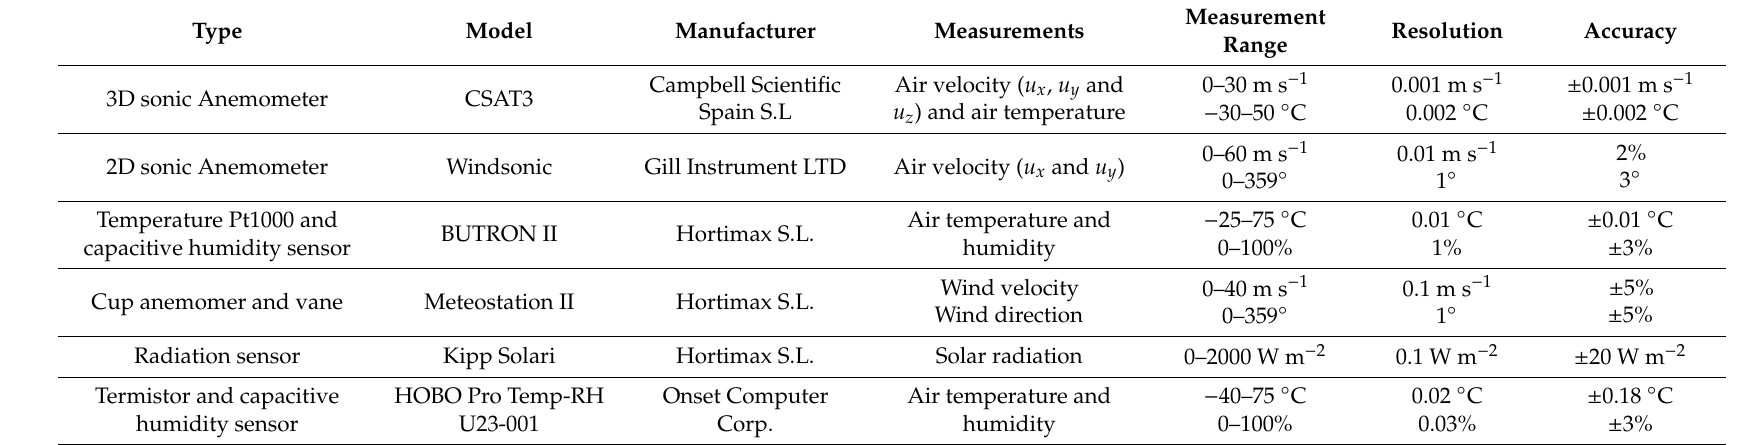
Table 2. Sensors used and their